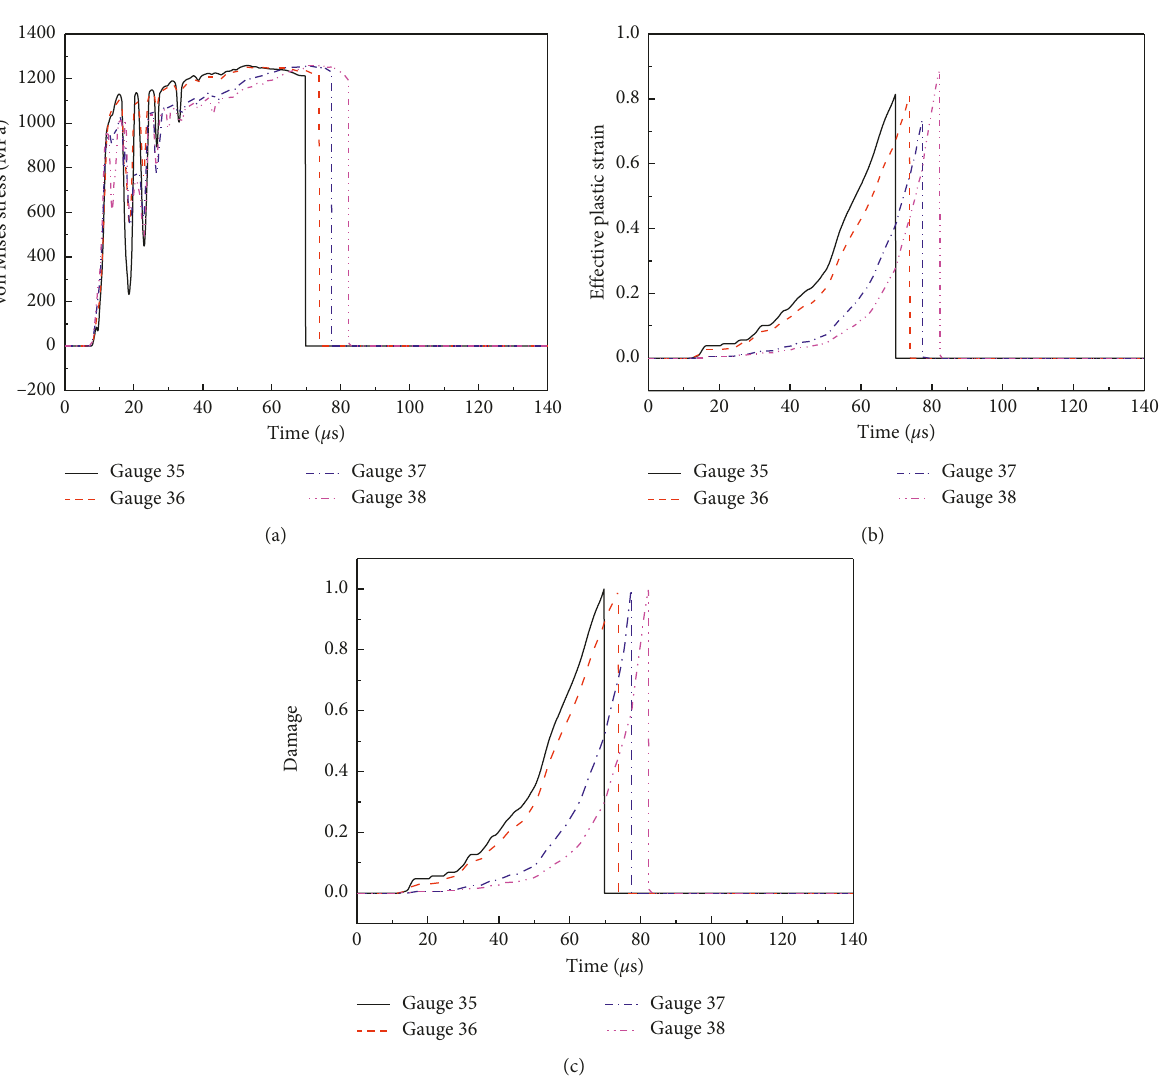
Figure 12: (a) von Mises stress; (b) effective plastic strain; (c) damage histories on the impair